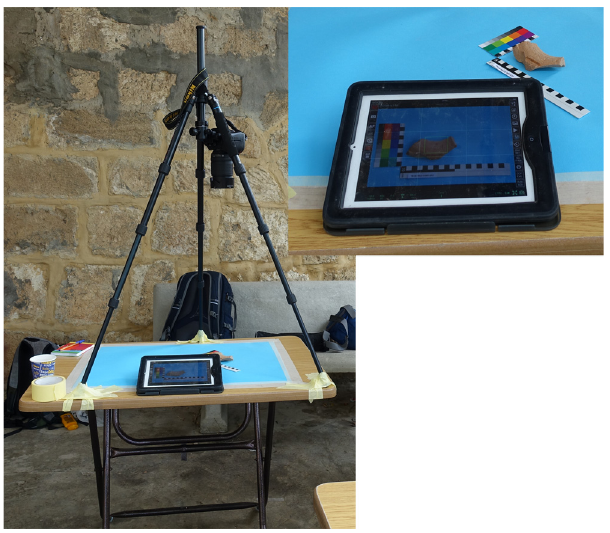
Figure 6: Workstation for taking photographs.